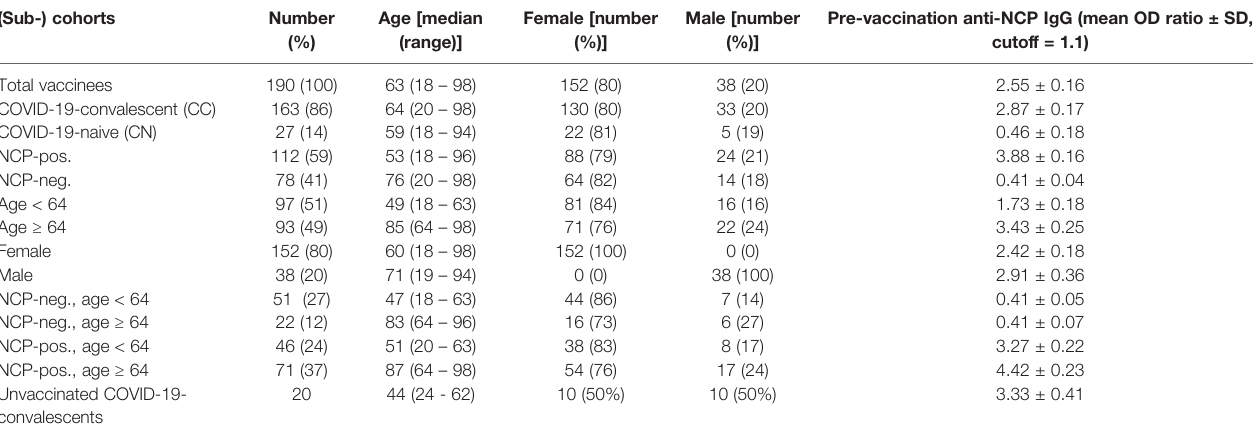
TABLE 1 | Age, gender and anti-SARS-CoV-2-NCP IgG titer characteristics of study subjects. (Sub-)